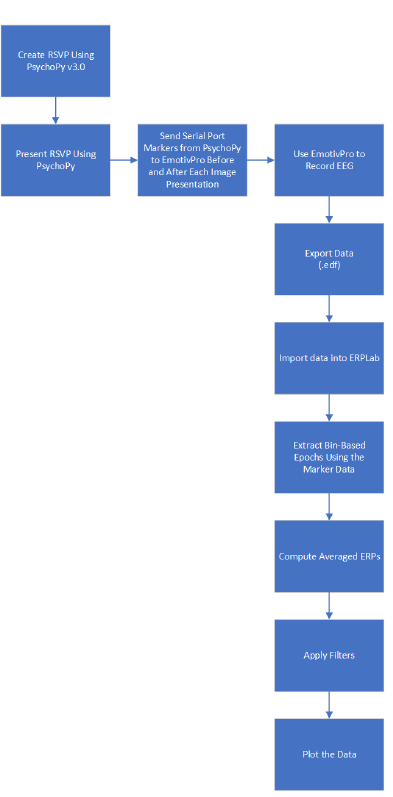
Figure 1. Geospatial Imaging - Event Related Potential